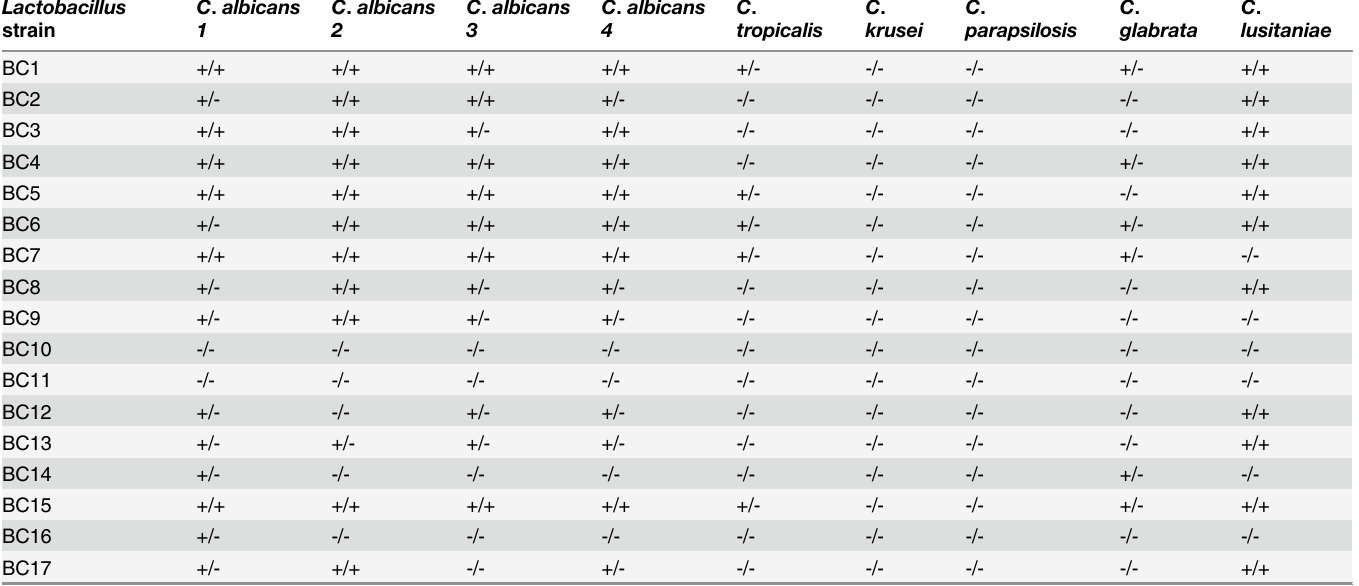
Table 2. Fungistatic/fungicidal activity of Lactobacillus strains against Candida isolates. Lactobacillus